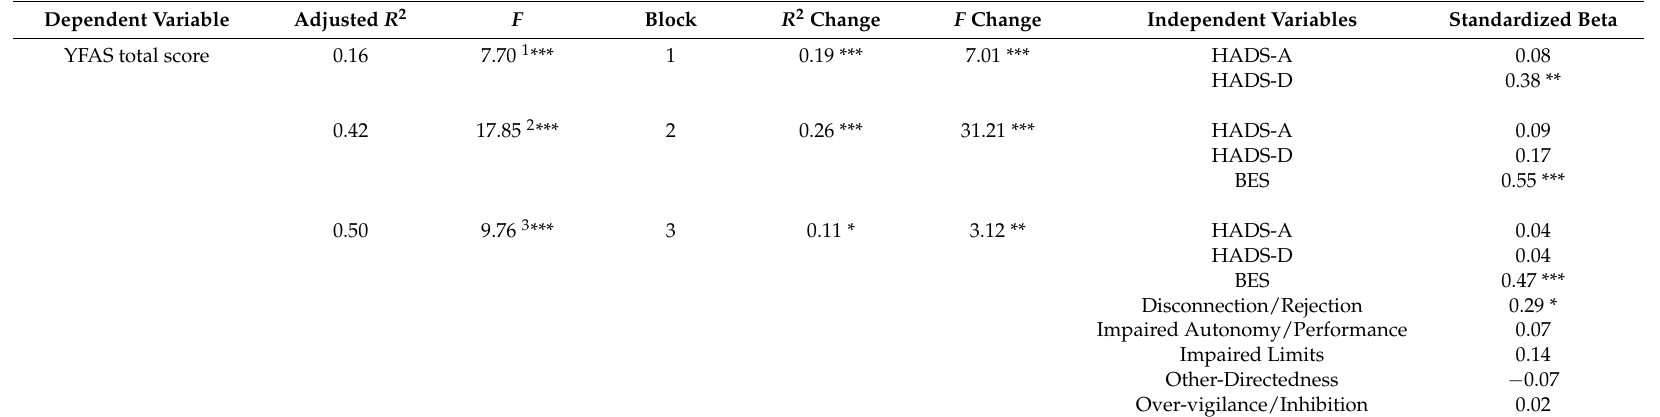
Table 3. Results of the hierarchical linear regression analysis ( N =